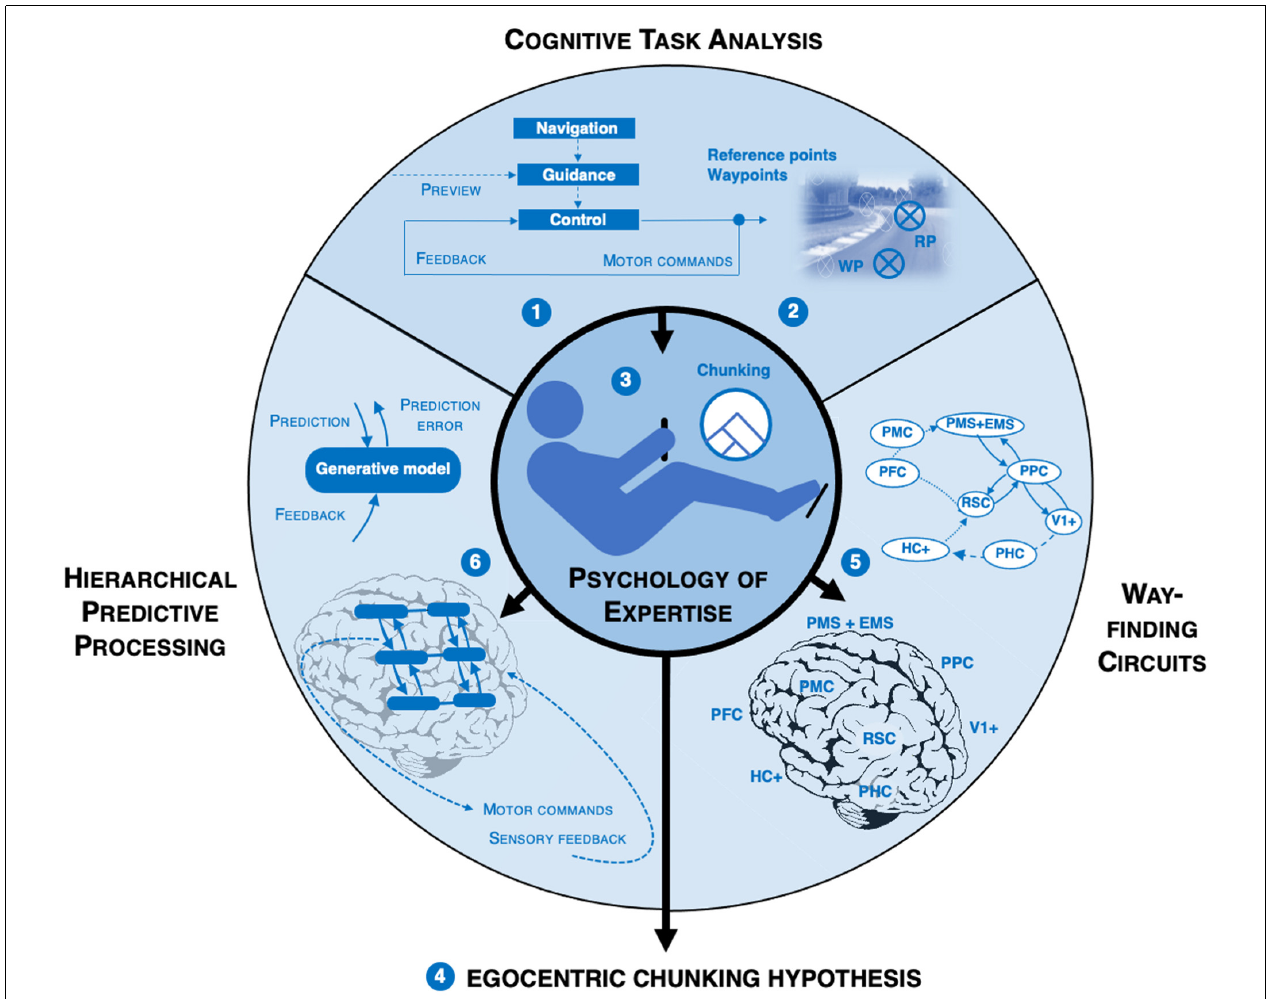
FIGURE 1 | Overview of the concepts and hypotheses, and how they are logically organized. Also a road map to the way the article is structured. Cognitive task analysis , based on computational driver modeling in vehicle system dynamics engineering (including racecar engineering). (1) Specifically: the McRuer et al. (1977) navigation-guidance-control hierarchy that has also been used to understand higher-level cognitive involved in visual guidance in real-world driving (Lappi and Mole, 2018). (2) Interpretation of the hierarchical task analysis in light of domain expert knowledge elicitation, specifically the reference point concept (Lappi, 2018). Waypoint identification and interception characterizing the driving task (Lappi, 2014; Lappi and Mole, 2018). Psychology of expertise . (3) Chunking recurring patterns into long-term memory structures allow fast, automatic pattern recognition. Enables superior performance of experts despite strict capacity limitations of attention and working memory (Glaser, 1985; Gobet et al., 2001). (4) Chunking combined with waypoint identification and consideration of different frames of reference (Lappi, 2016) into the egocentric chunking hypothesis . (5) Interpretation of this hierarchical task structure/cognitive organization in terms of a neural hierarchy in cognitive neuroscience; wayfinding circuits in the brain involved in landmark-based navigation and representation of large-scale environments (Barry and Burgess, 2014; Epstein and Vass, 2014; Spiers and Barry, 2015; Epstein et al., 2017) and driving (Lappi, 2015; Navarro et al., 2021). (6) Hierarchical predictive processing (predictive brain) in cognitive modeling; the brain as an inference engine for stochastic estimation and control (Friston, 2009, 2010; Friston et al., 2012; Clark, 2013; on predictive processing in driving, see also Engström et al., 2018; Kujala and Lappi,